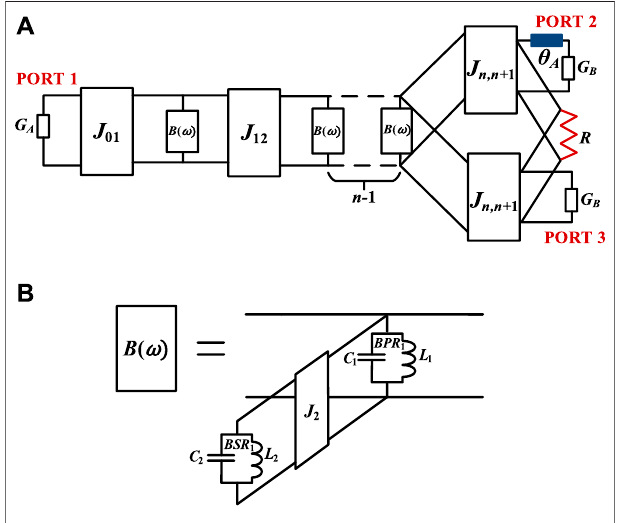
FIGURE 1 | (A) Topology of n th-order dual-band FPD. (B) Inverter- coupled resonator sections B ( ω ).